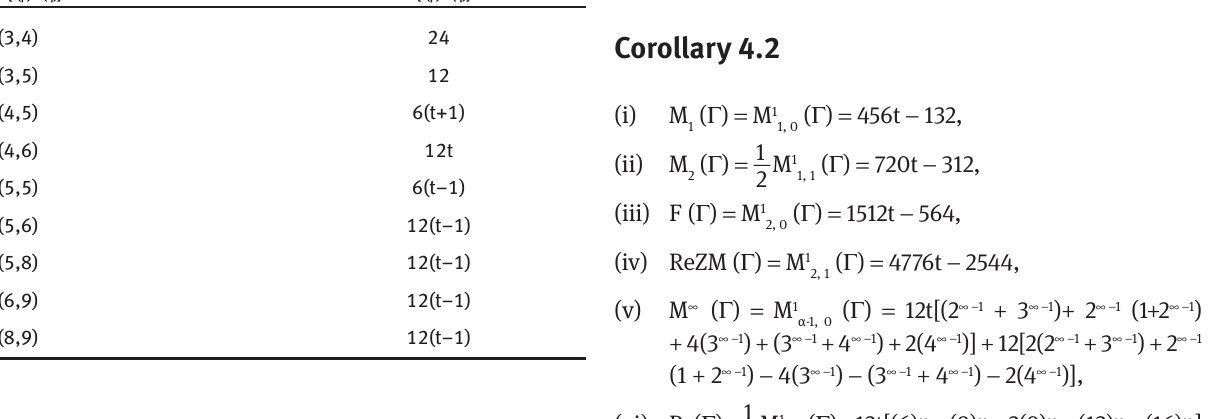
(t) that is based on 1